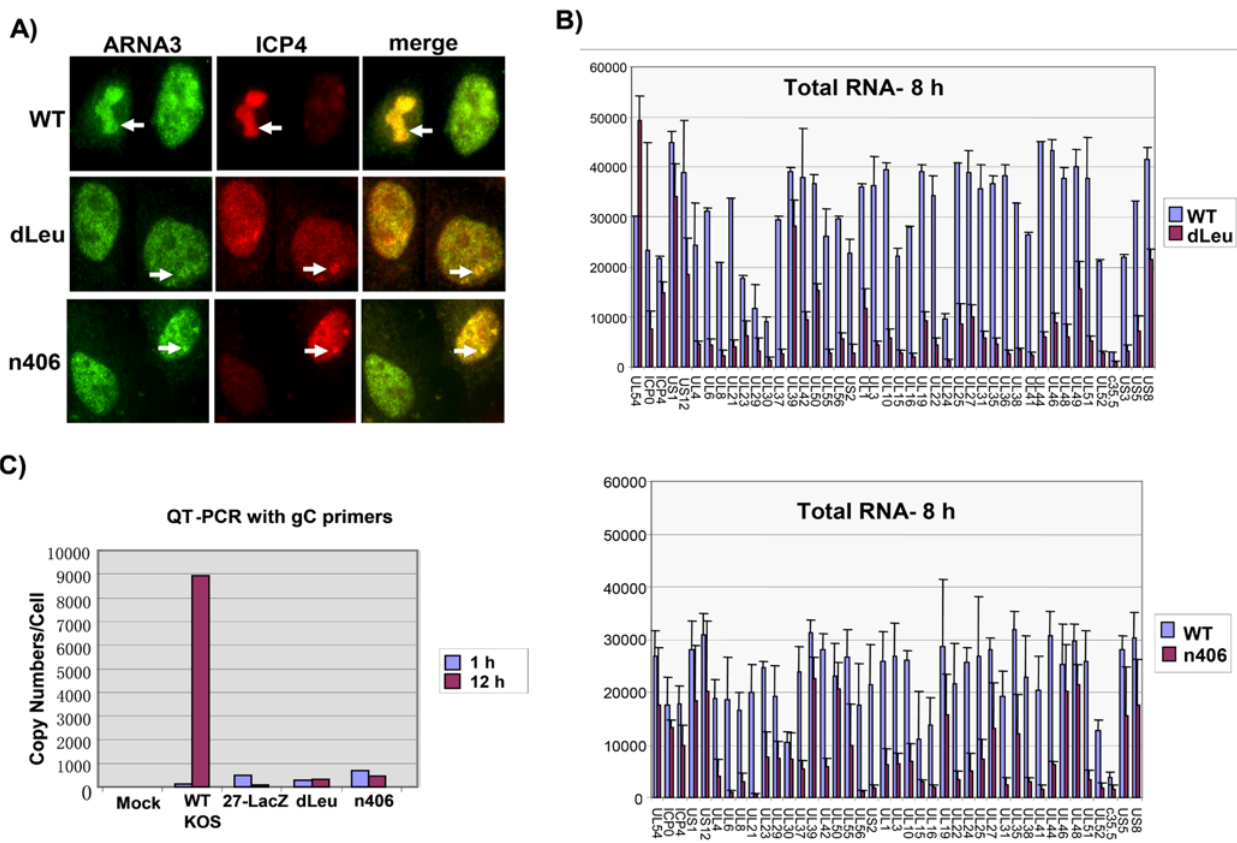
Figure 5. ICP27 N- and C-Terminal Mutants Show Poor Replication Compartment Formation and Reduced Transcription and DNA Replication. A) Vero cells were infected with WT HSV-1, dLeu or n406 for 8 h, at which time cells were fixed and stained with anti-RNAP II antibody ARNA3, which recognizes all forms of RNAP II, and anti-ICP4 antibody. The arrows point to a fully formed replication compartment in WT-infected cells and to small pre-replication sites in dLeu and n406-infected cells. B) HeLa cells were infected with WT HSV-1, dLeu or n406 as indicated. At 8 h after infection total RNA was extracted and microarray analysis was performed as described previously against an array of HSV-1 transcript-specific probes [35]. Hybridizations were performed in triplicate and the experiments were performed twice. Error bars represent the standard deviations. C) Vero cells were mock-infected or were infected with WT HSV-1, 27-LacZ, dLeu or n406 at a moi of 10. At 1 h and 12 h after infection, DNA was purified from cell lysates by phenol-chloroform extraction. Quantitative real-time PCR was performed with a probe for the glycoprotein C (gC) gene to determine viral DNA copy number.